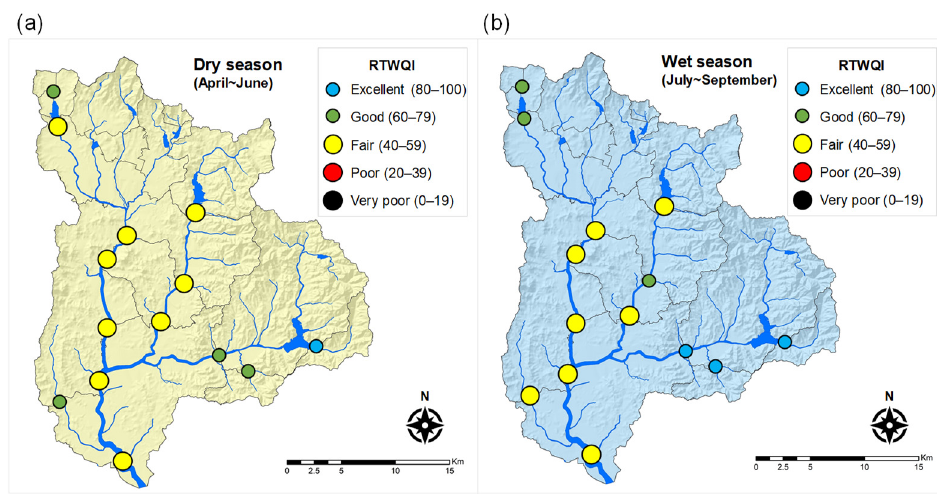
Figure 4. Results of the RTWQI during the dry ( a ) and wet season ( b ).